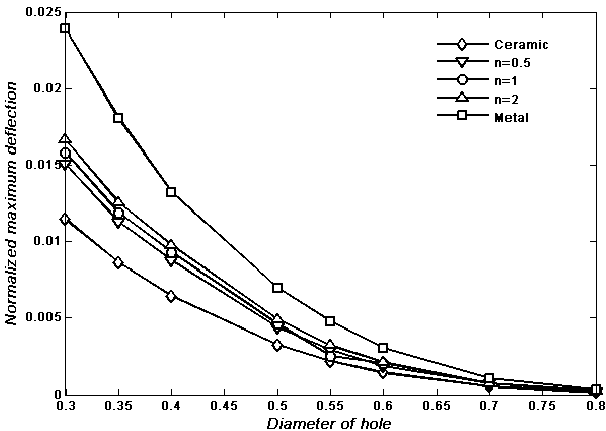
Figure 17. Normalized maximum deflection w ∗ = wE Al h 3 / q versus diameter R h of the hole with internal clamped boundary conditions under a transverse uniform load q .